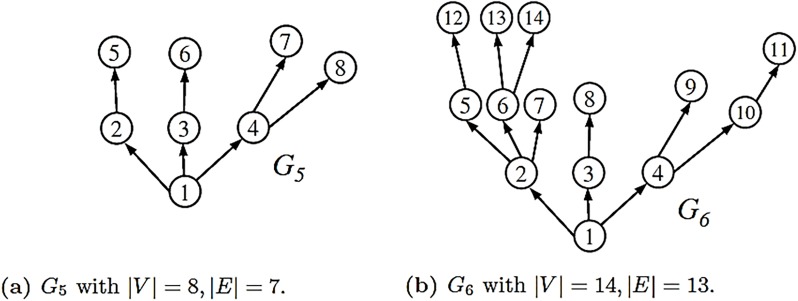
The two example graphs G5 and G6.